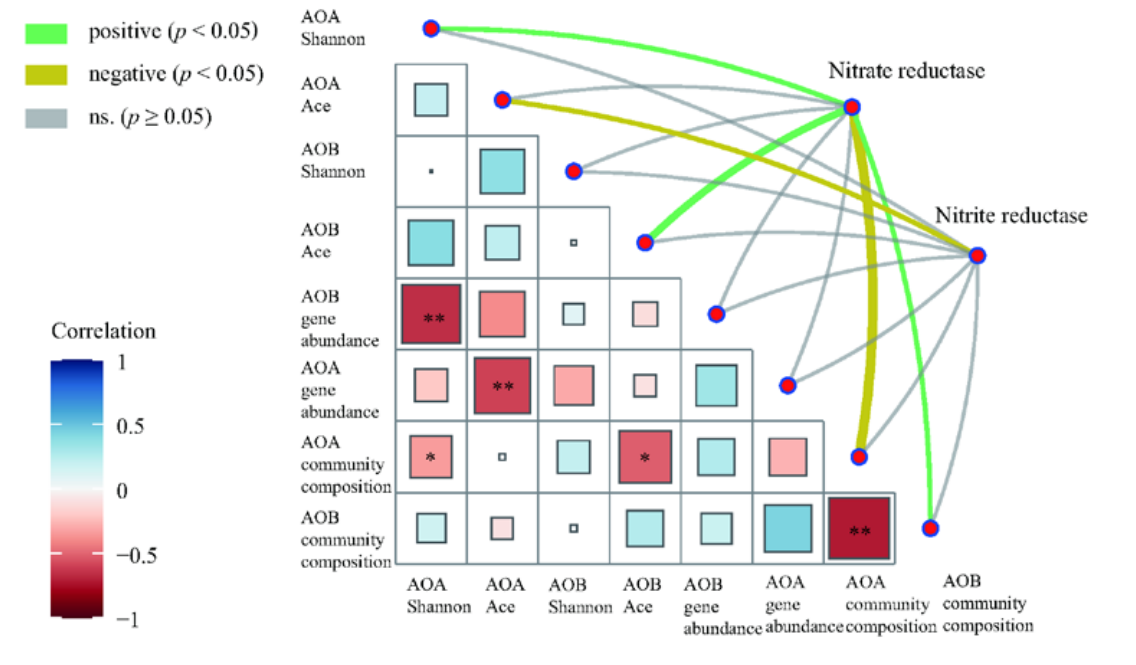
Figure 7. Correlation of N-cycle enzymes with AOA and AOB microbial community. Pairwise comparisons of AOA and AOB gene abundance, community diversity, and community composition with a color gradient denoting the Spearman’s correlation coefficients. Enzymes were related to each microbial community factor by Mantel test. The width of edges corresponds to the Mantel’s statistic for the corresponding distance correlations. The color of the edges represents the positive and negative values of r. * p < 0.05, ** p < 0.01.